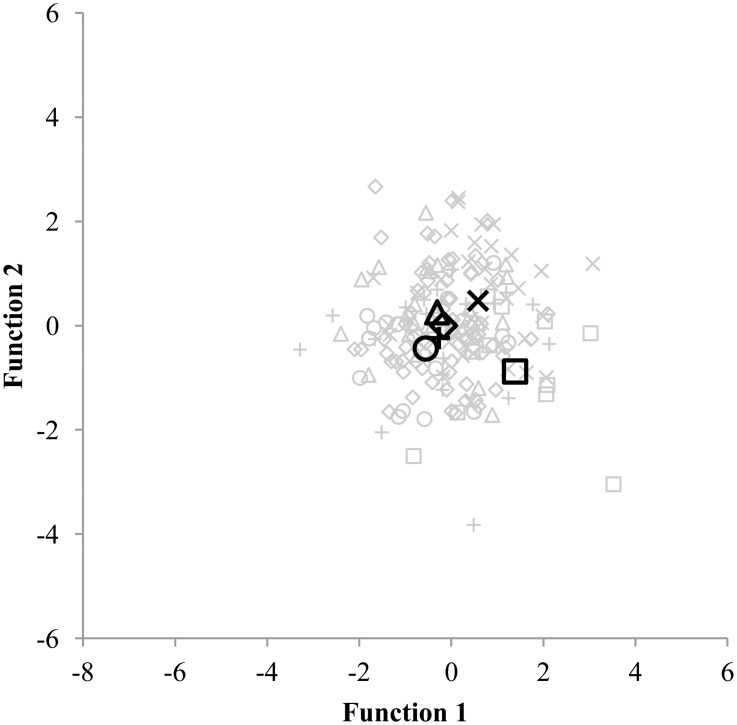
Discriminating between 184 children participating 1 hour or less per week in their sport.Functions at Group Centroids: Ball sports Function 1 = -0.556; Ball sports Function 2 = -0.441; Dance Function 1 = -0.169; Dance Function 2 = 0.000; Gymnastics Function 1 = -0.270: Gymnastics Function 2 = -0.240: Martial arts Function 1 = 1.384; Martial arts Function 2 = -0.881; Racquet sports Function 1 = -0.307; Racquet sports Function 2 = 0.254; Swimming Function 1 = 0.580; Swimming Function 2 = 0.475. Ball sports = ○; Dance = ◆; Gymnastics = +; Martial arts = ☐; Racquet sports = Δ; Swimming = ×.